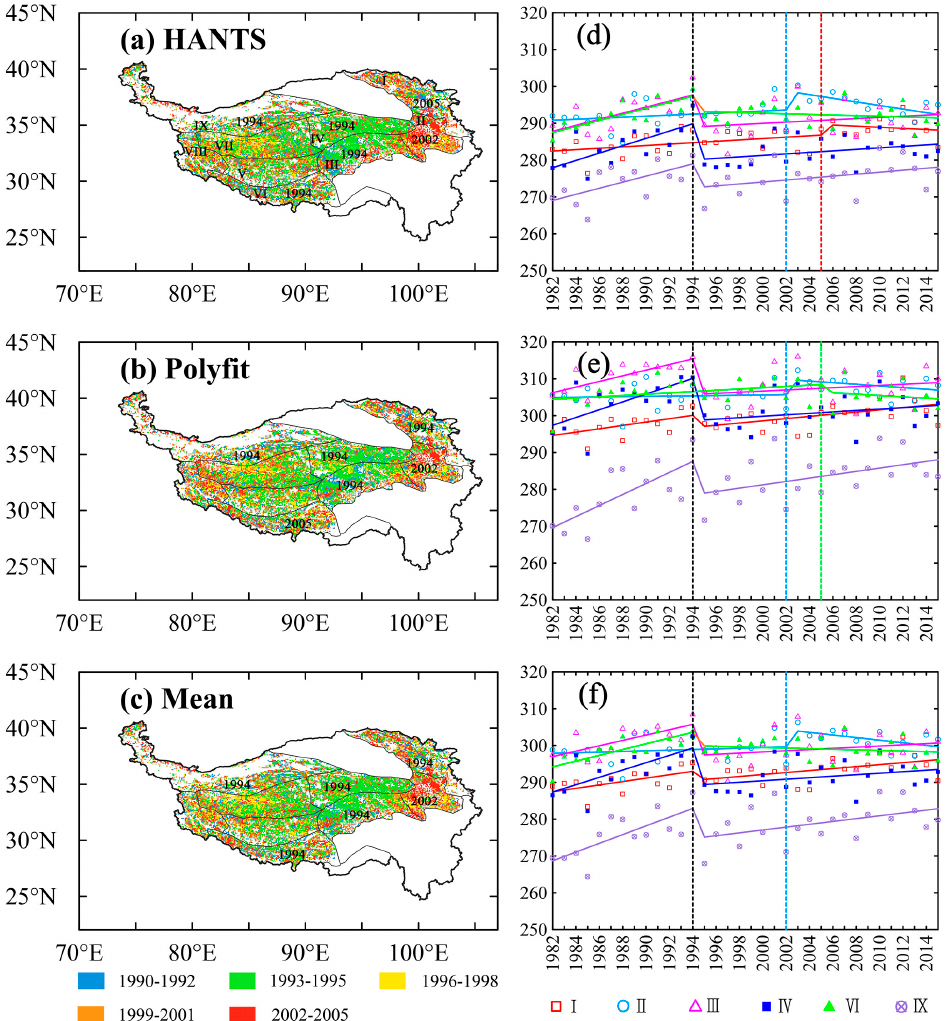
Figure 4. Turning point distributions and variations for subregions. ( a – c ) EOS turning points distributions with results of HANTS, Polyfit, and their mean values. The numbers represent the modes of the turning years in each subregion. ( d – f ) Scatter plots and results of piecewise regressions with the results of HANTS, Polyfit, and their mean values. The vertical dashed lines represent the turning points in the different subregions.